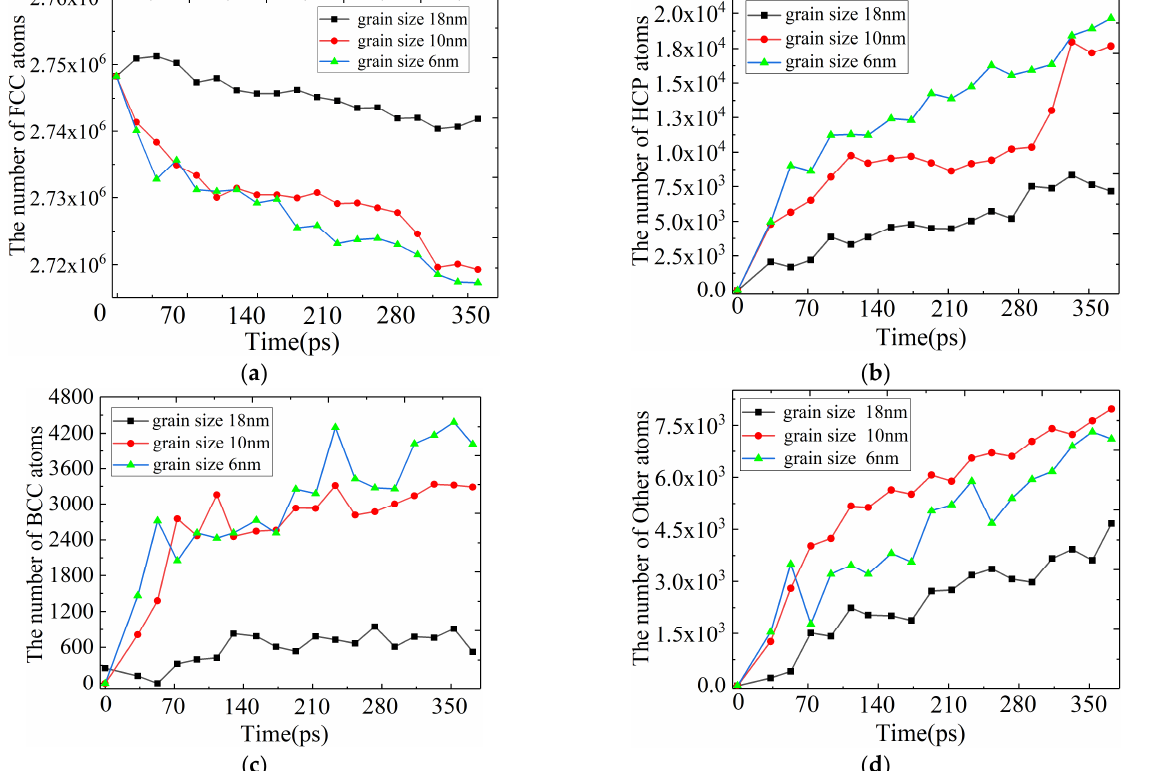
Figure 18. The change of the number and types of defect atoms with different grain sizes, and ( a – d ) are the number of atoms of fcc, hcp, bcc, and other respectively.